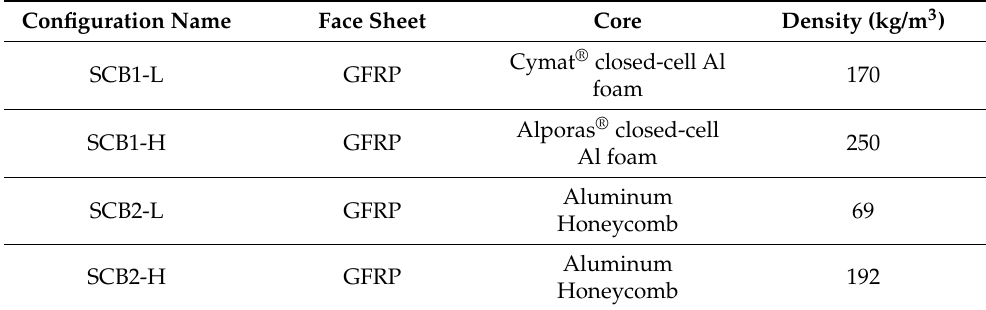
Table 2. The nomenclature and material configurations used for the sets of SCB